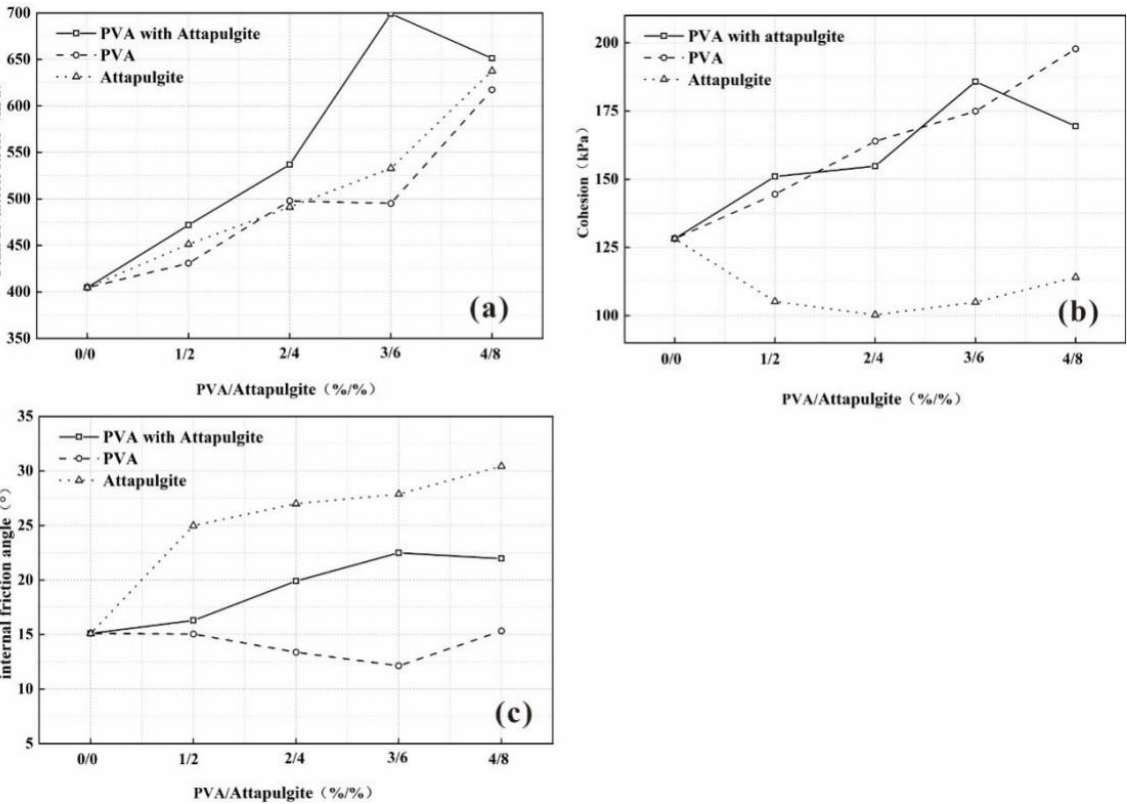
Figure 9. ( a ) The peak deviator stress curve, ( b ) cohesion curve and ( c ) internal friction angle with different amounts of PVA and attapulgite replacement.